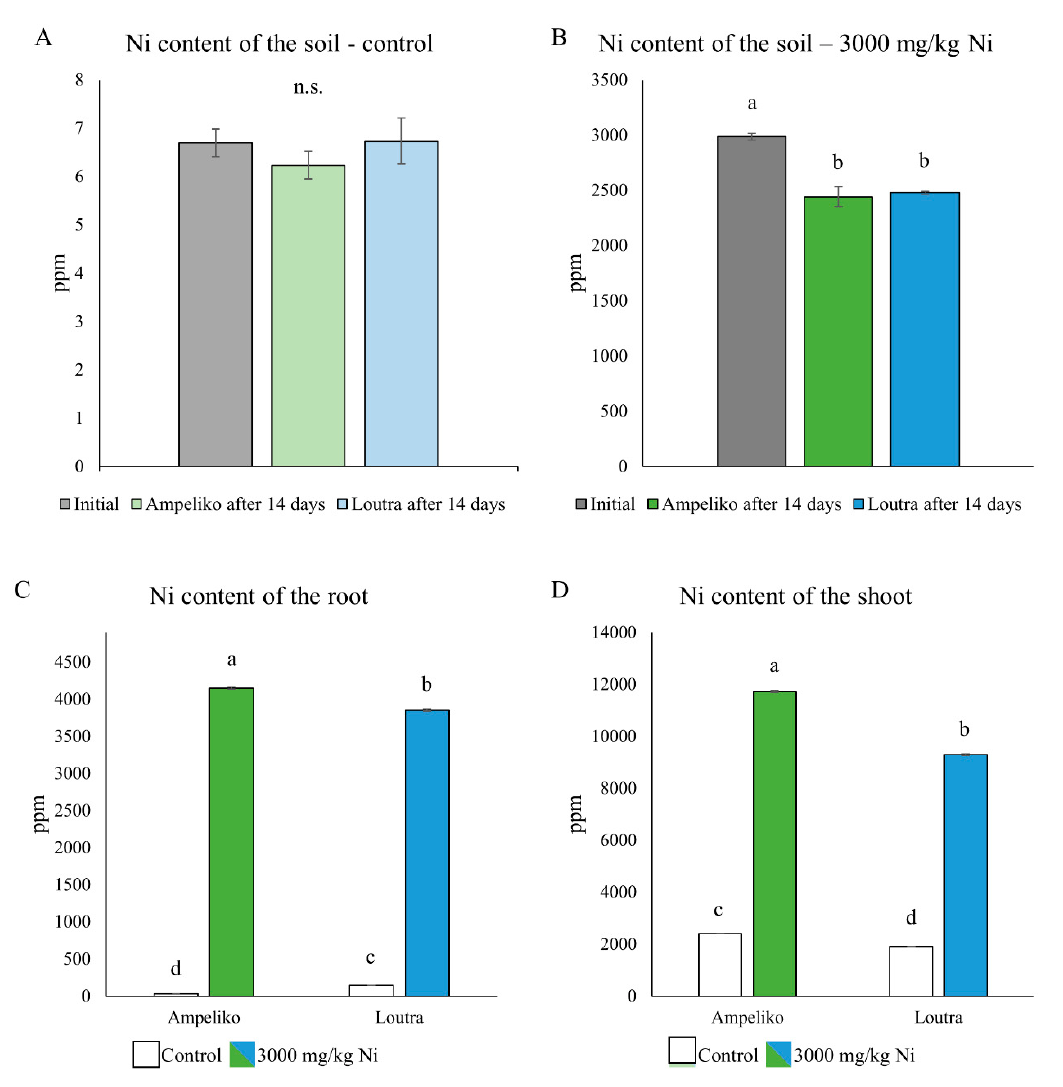
Figure 1. Nickel content of the control soil ( A ) and the soil containing 3000 mg/kg Ni ( B ) before and after 14 days of plant growing in them. Ni content of the roots ( C ) and shoots ( D ) of O. lesbiaca from the two different habitats. Different letters indicate significant differences according to Duncan-test ( p < 0.05), n.s. means no significant difference.